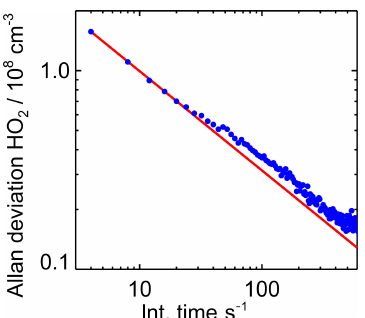
Figure 4. Allan deviation plot derived from sampling a constant HO 2 concentration of 1 × 10 8 HO 2 moleculescm − 3 over 5h. The Allan deviation demonstrates the precision of measurements de- pending on the integration time. The red line indicates the behaviour of the Allan deviation if the noise is only limited by Gaussian